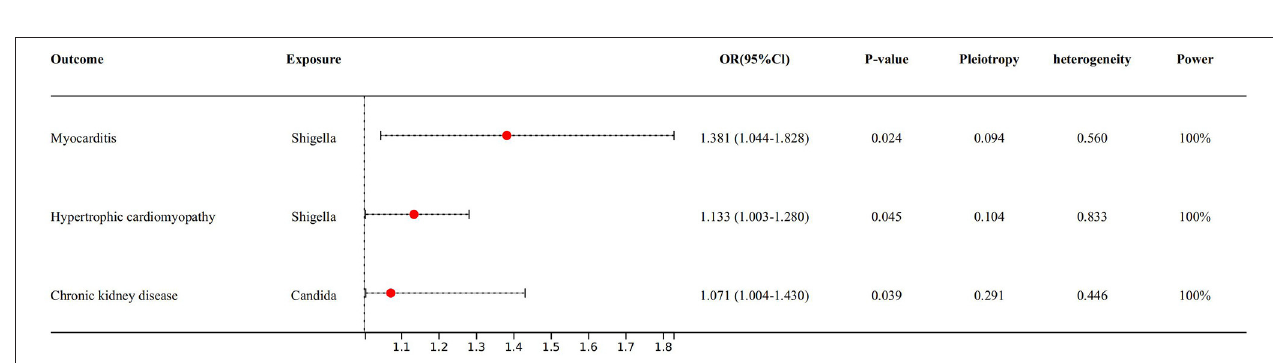
FIGURE 2 | Forest plot to visualize the causal effect of Gut microbiota on the risk of heart failure by inverse variance weighted method.